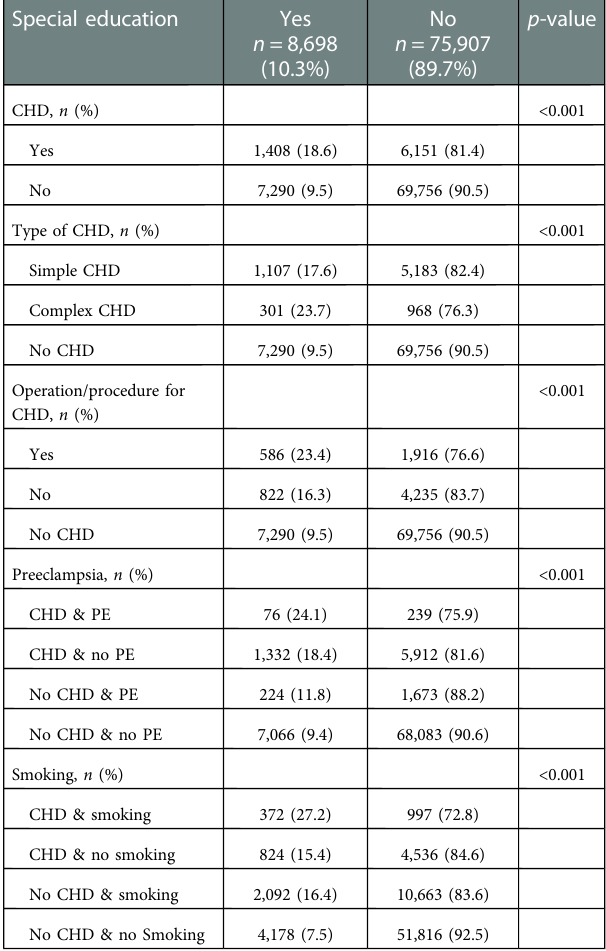
TABLE 2 Frequency table of children receiving special education strati fi ed on subgroups. Special education